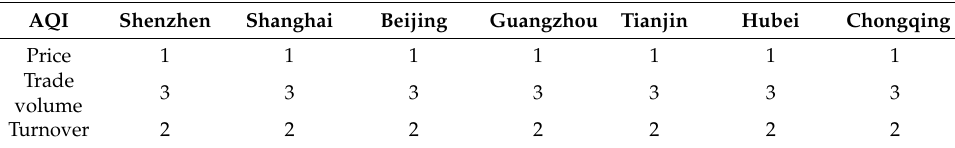
Table 12. Rank of relational degree of AQI (Air Quality Index) and price, trade volume, and turnover selected influence factors in IC-GRA